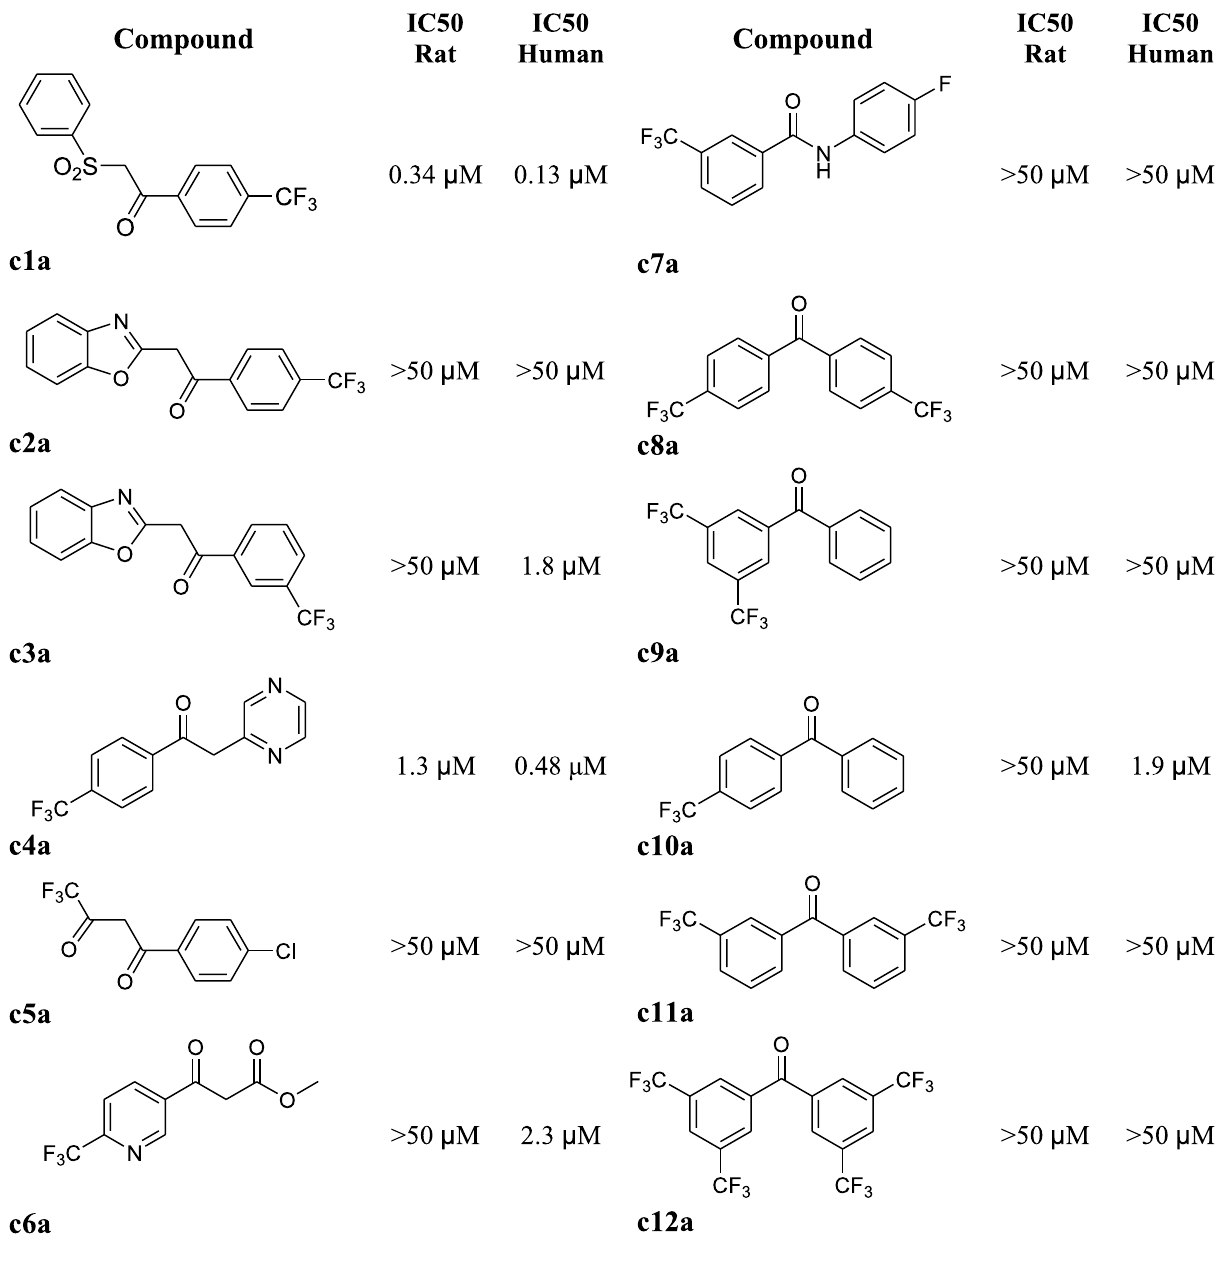
Figure 3. Screening putative polyfluorinated tracers for competition with cortisone for metabolism by 11β- HSD1. Inhibition of cortisone reductase activity by potential fluorinated keto tracers ( c1a – c12a ) thought likely to be substrates for 11β-hydroxysteroid dehydrogenase (11β-HSD 1) was evaluated in HEK293 stably transfected with human or rat Hsd11b1. IC 50 values represent the mean of two